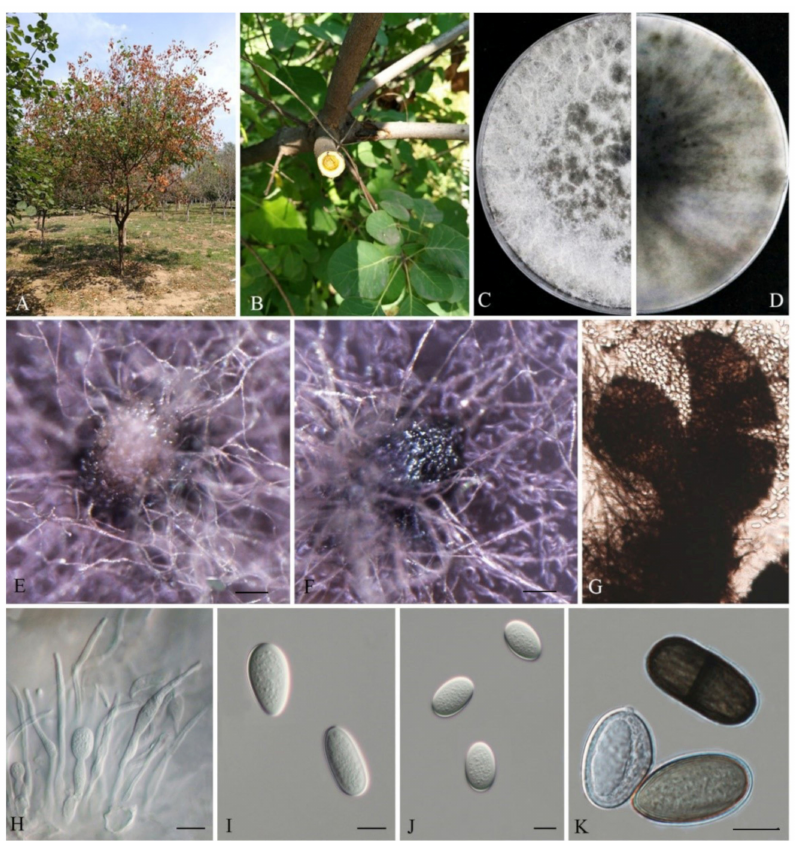
Figure 3. Lasiodiplodia cotini (JZBPG 1905). ( A ) Diseased tree in the field. ( B ) Cross-section of the blighted stem. ( C , D ) Culture grown on PDA. ( E , F ) Conidiomata developing on PDA. ( G ) Crushed conidiomata with many conidia. ( H ) Conidia developing on conidiogenous cells between paraphyses. ( I – K ) Conidia. Scale bars: E − F = 100 µ m, H − K = 10 µ